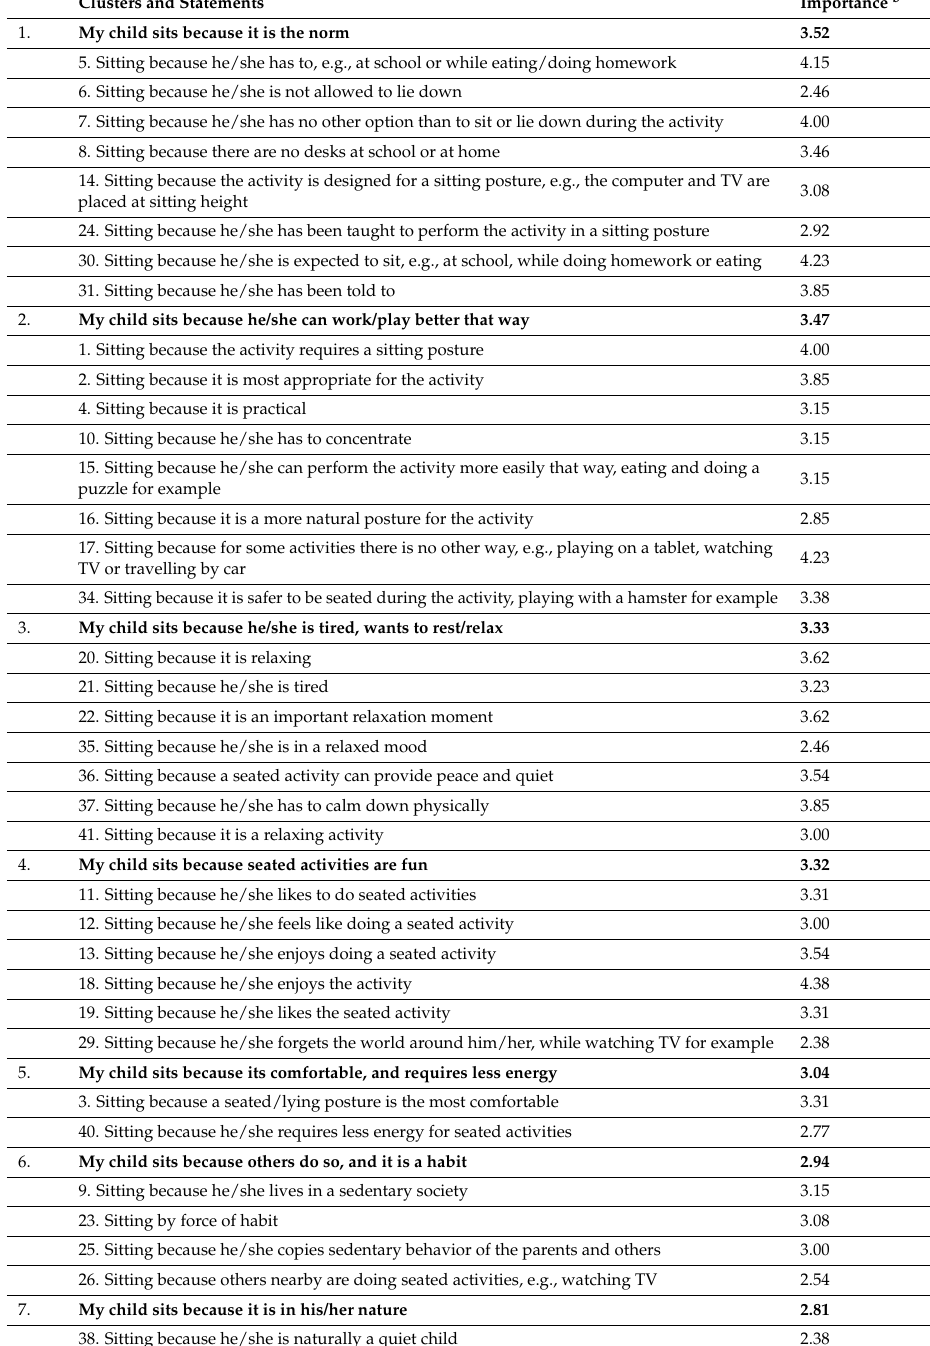
Table A6. Clusters, statements and importance ratings of parents (convenience sample) a